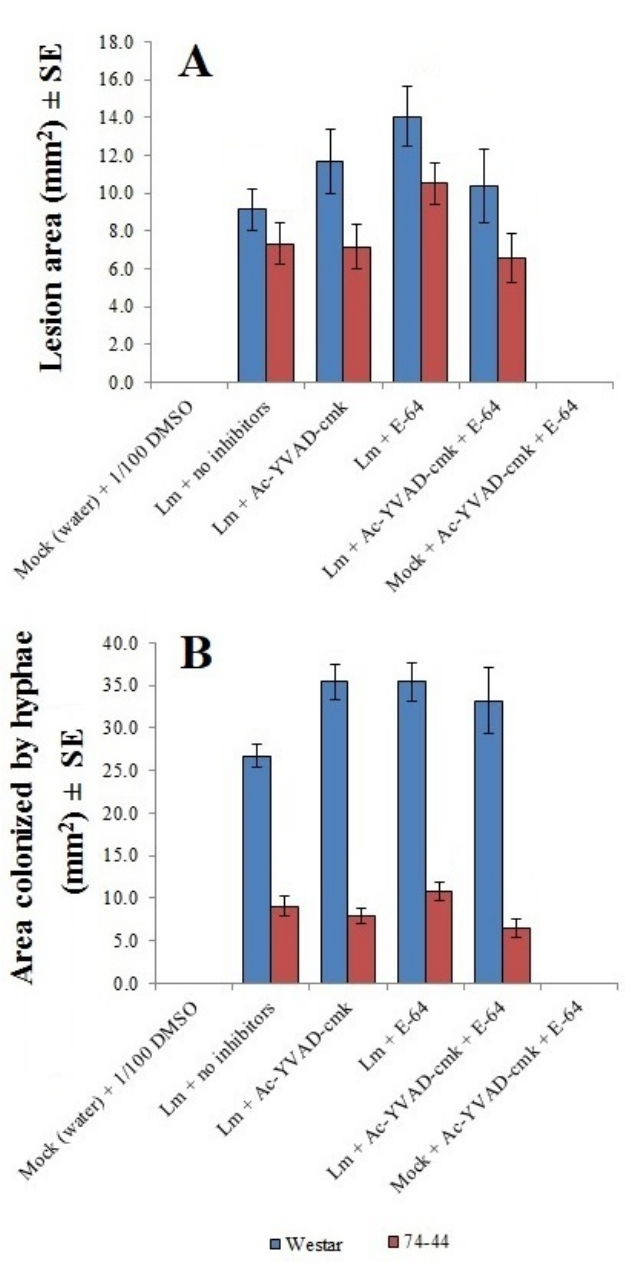
Figure 9. Impact of protease inhibitors on lesion size ( A ) and area colonized by Lm hyphae ( B ) in the cotyledons of Westar and 74-44 BL at 7 dpi.